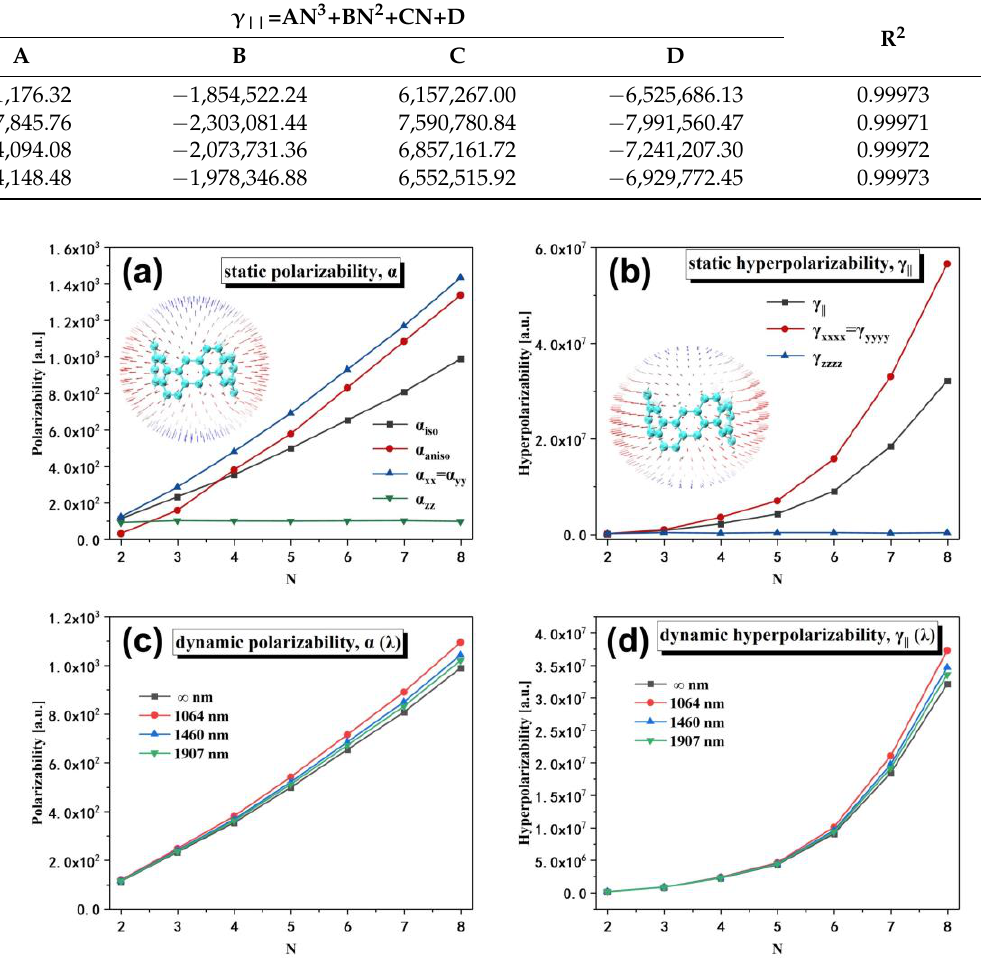
Figure 10. Static ( a ) and dynamic ( c ) polarizability of [2N,2N]CNB; static ( b ) and dynamic ( d ) second hyperpolarizability of [2N,2N]CNB. Table 1. The extrapolation formula of the polarizability of [2N,2N]CNB under different external fields.